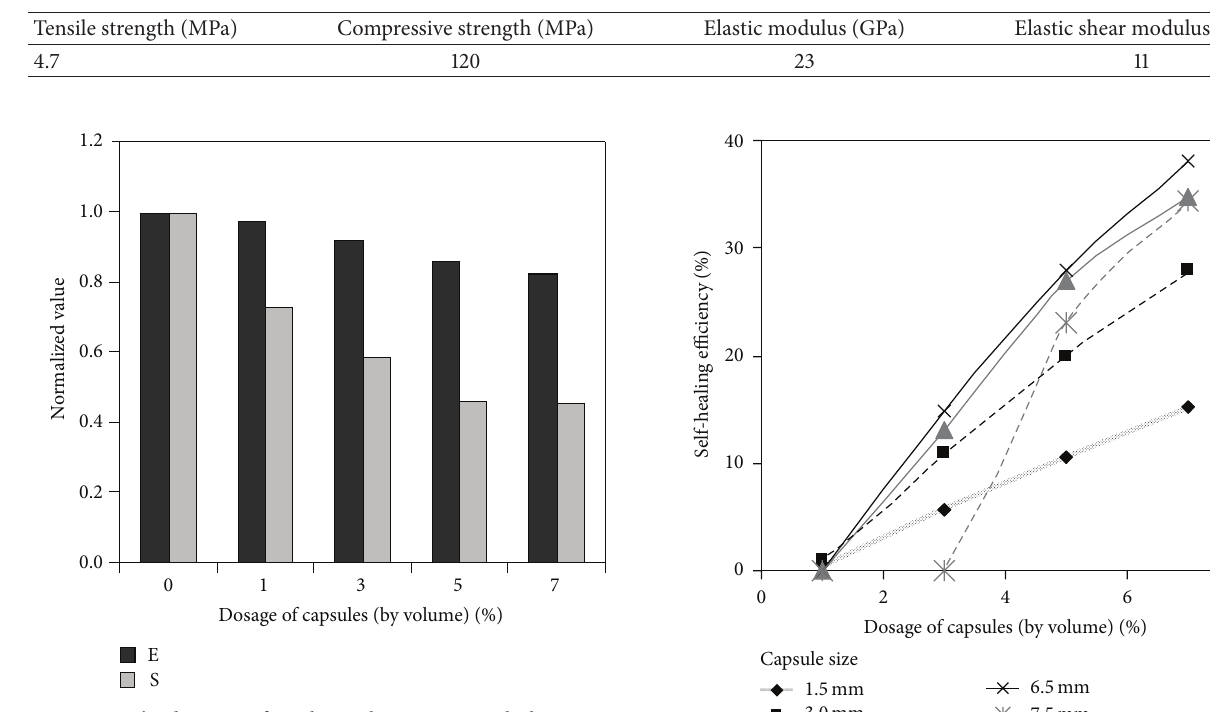
Figure 15: The decrease of mechanical properties with the increase of capsules (E: elastic modulus; S: tensile strength).